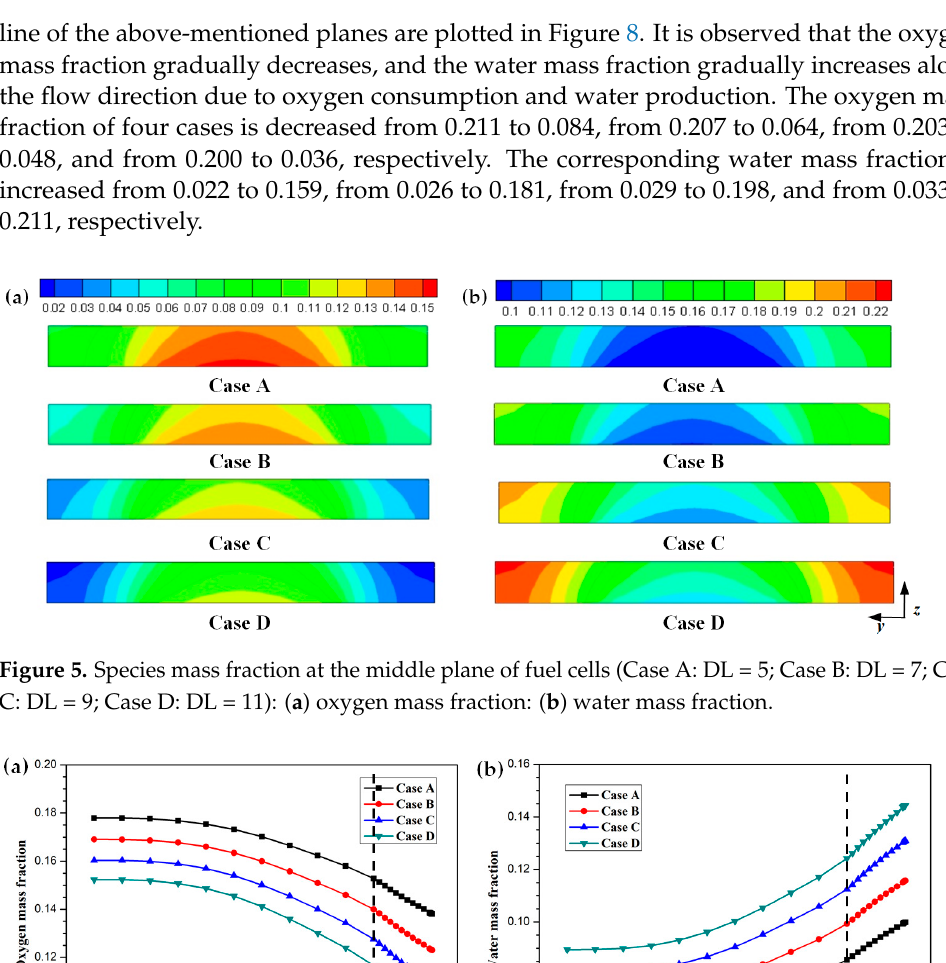
Figure 8. Species mass fraction profile distributions at y = 0.001 m (Case A: DL = 5; Case B: DL = 7; Case C: DL = 9; Case D: DL = 11): ( a ) oxygen mass fraction; ( b ) water mass fraction. The proton conductivities of the membrane of four cases at the cell voltage 0.3 V are given in Figure 9. It can be observed that the proton conductivity is gradually increased from Case A to Case D, and the proton conductivities of four cases are 4.82 S/m, 6.58 S/m, 8.96 S/m, and 12.20 S/m, respectively. Local current densities of four cases at the cell volt- age 0.3 V are demonstrated in Figure 10. It is clearly observed each local current density profile is symmetrically distributed, and it is also gradually decreased along the flow di- rection. This is because the oxygen is gradually consumed along the flow direction and the molar concentration is also decreased. As shown in Figure 10a, the minimum current density is observed at the middle of the GFC region. The maximum current density is obtained by Case D, followed by Case C, Case B, and Case A. The local current density at the middle of the plane is given in Figure 10b. It can be seen that the current density of Case D and Case C sharply decreases at the rib regions, while that of Case B and Case A only slightly decreases at the same regions. In Figure 10c, Case D provides the maximum and minimum local current densities of four cases. This means that the current density of Case D is extremely non-uniformly distributed in comparison with other cases.